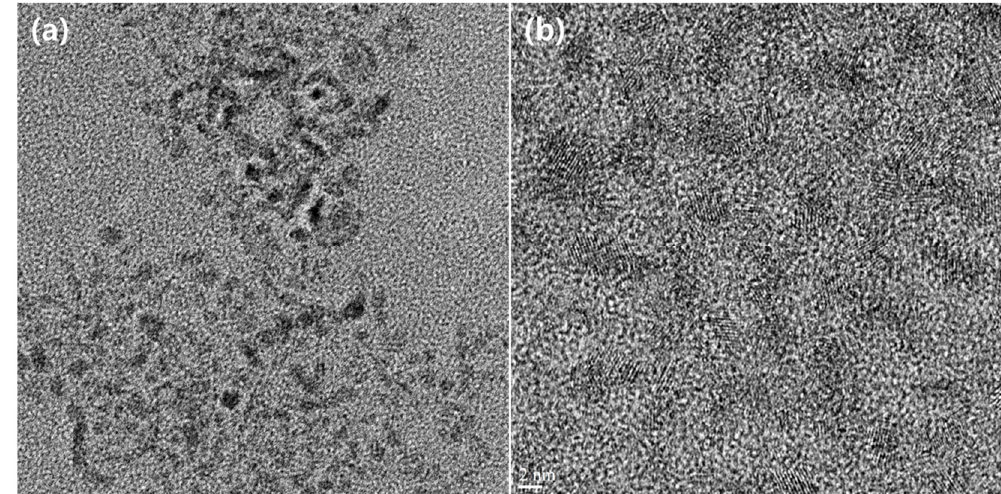
Figure 5. The TEM images of the synthesized quantum dot after one month. The particles are well-dispersed in water and are not aggregated in the images of TEM.